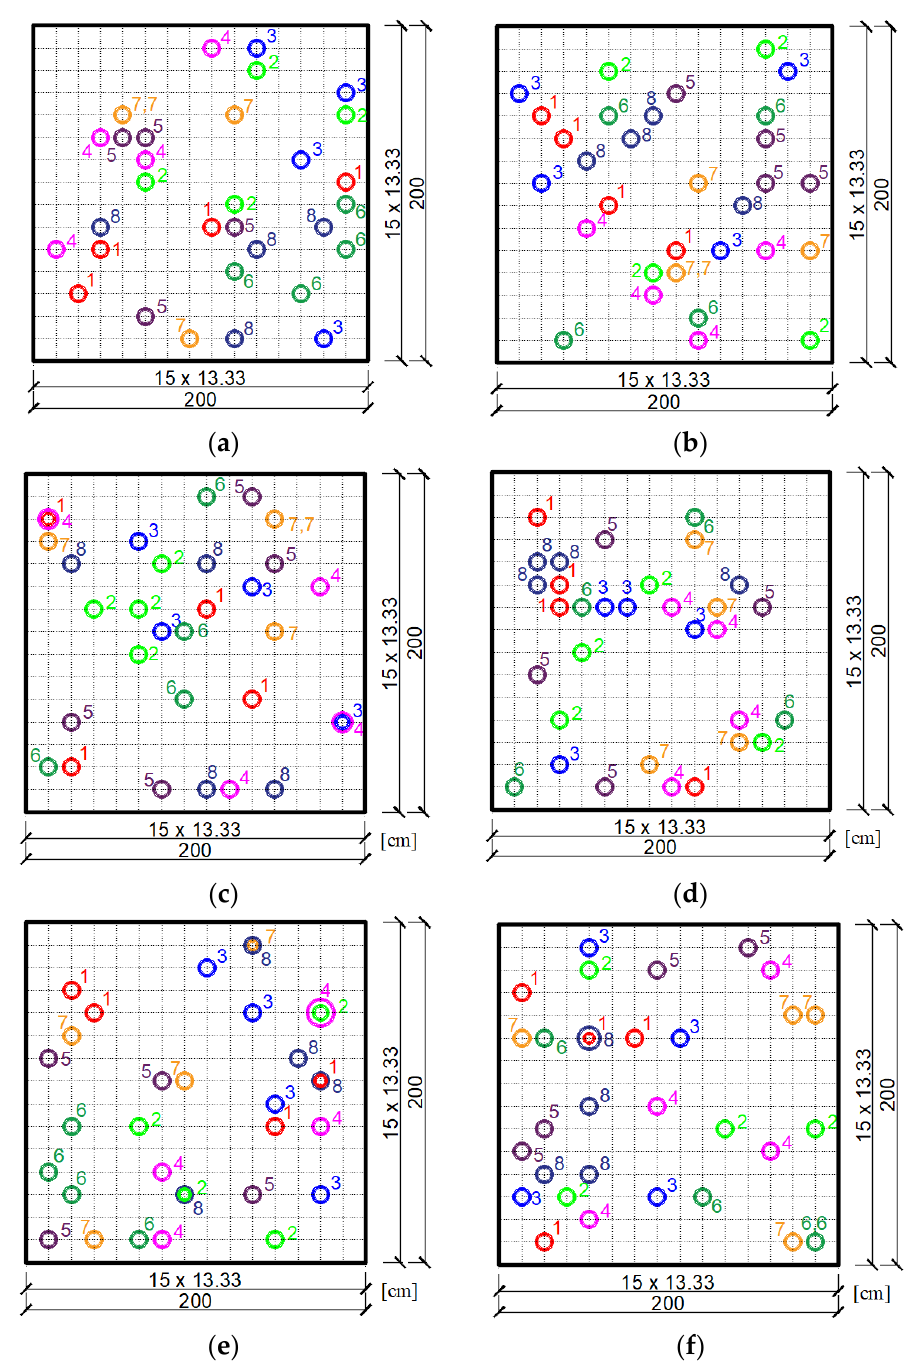
Figure 8. Initial swarm of particles (groups of four dampers) chosen randomly for the plate: ( a ) Neighborhood 1 for draw 1; ( b ) Neighborhood 2 for draw 1; ( c ) Neighborhood 1 for draw 2; ( d ) Neighborhood 2 for draw 2; ( e ) Neighborhood 1 for draw 3; ( f ) Neighborhood 2 for draw 3.